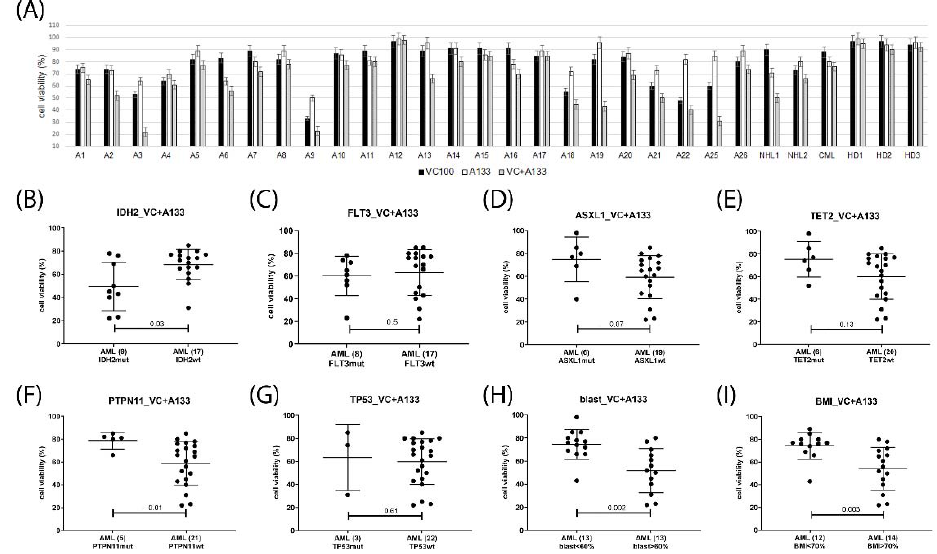
Figure 7. Response markers in venetoclax and A1331825 combination treatment. Cell viability was determined in mononuclear cells isolated from AML patients peripheral blood or bone marrow after 20 h treatment with 100 nM venetoclax and 1 µ M A1331825 ( A ). Hematological cells were grouped according to single gene mutation status of IDH2 ( B ), FLT3 ( C ), ASXL1 ( D ), TET2 ( E ), PTPN11 ( F ), TP53 ( G ), peripheral blast cell percentage ( H ), bone marrow blast cell percentage ( I ). Number of samples in each group are indicated in parentheses. Significance of differences in median values was calculated by Mann–Whitney test.